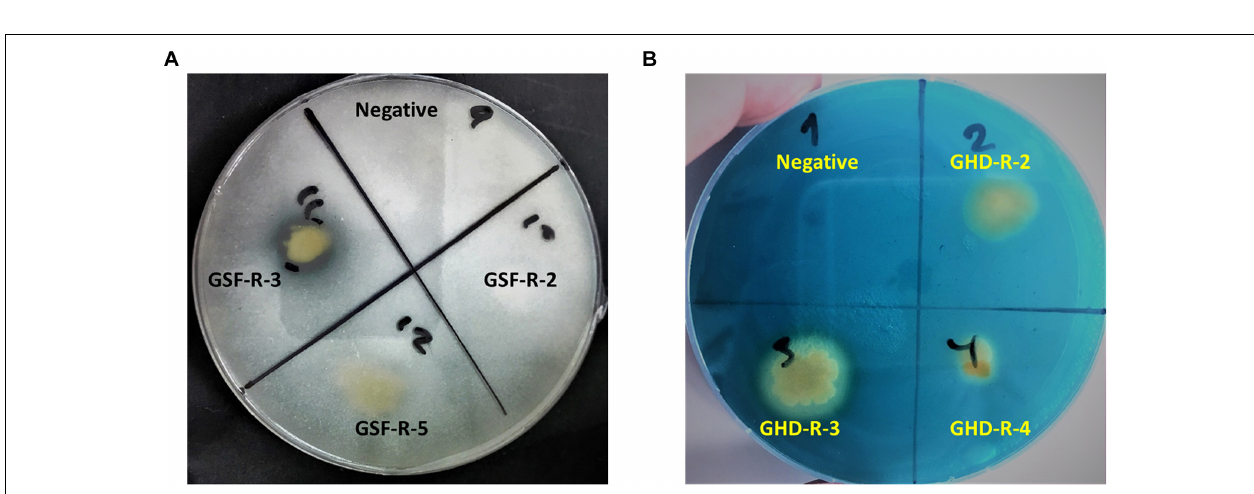
FIGURE 3 | (A) Phosphate-solubilizing activity (B) and siderophore production in selected halotolerant bacterial strains associated with durum wheat in this study. Negative indicates no bacteria inoculation.